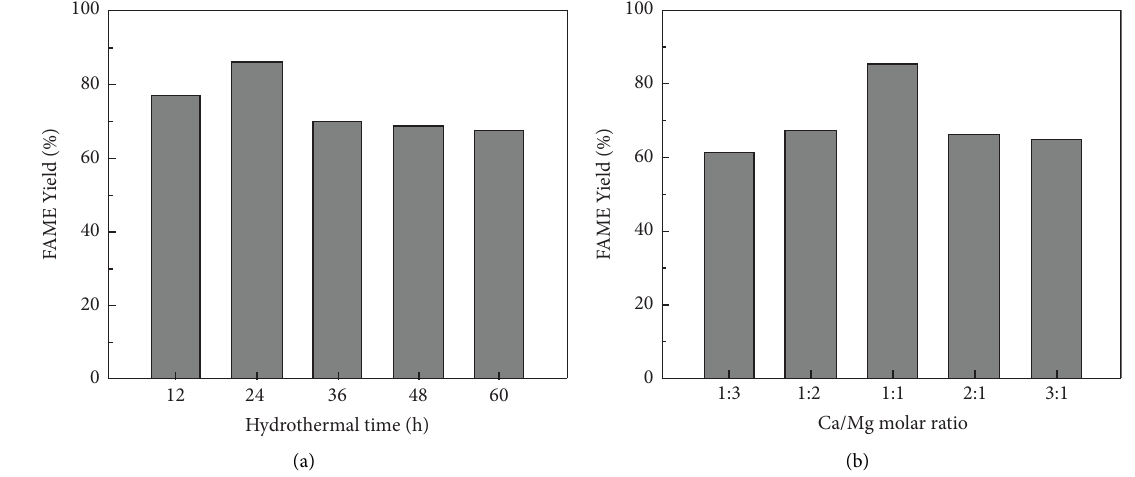
Figure 4: N 2 adsorption-desorption isotherms of KF/Mg-Ca-Al HTLCs MS (Ca/Mg calcined at 773K, and KF load ratio of